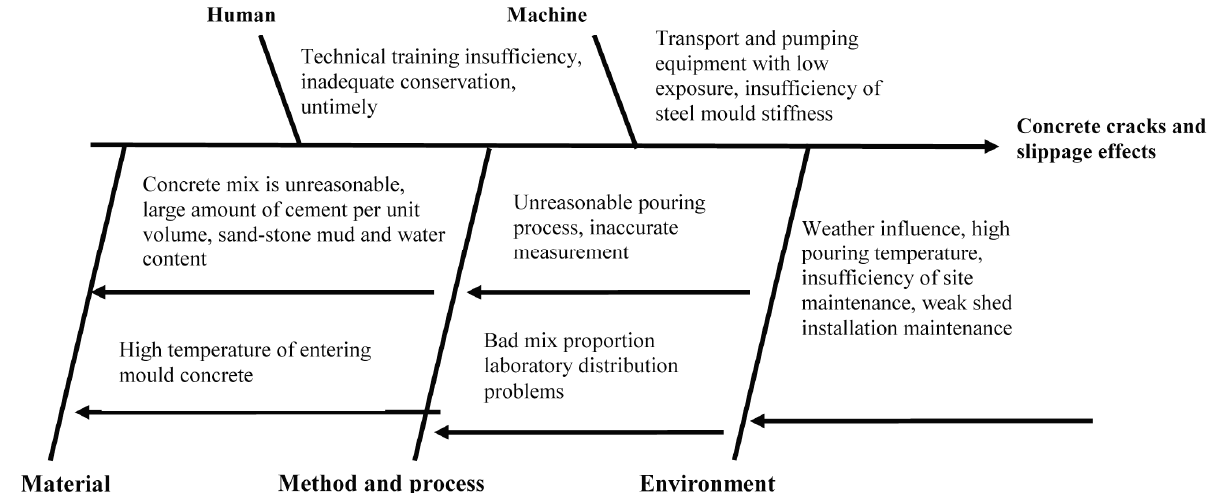
Fig. 2. Cause and effect diagram (CE)